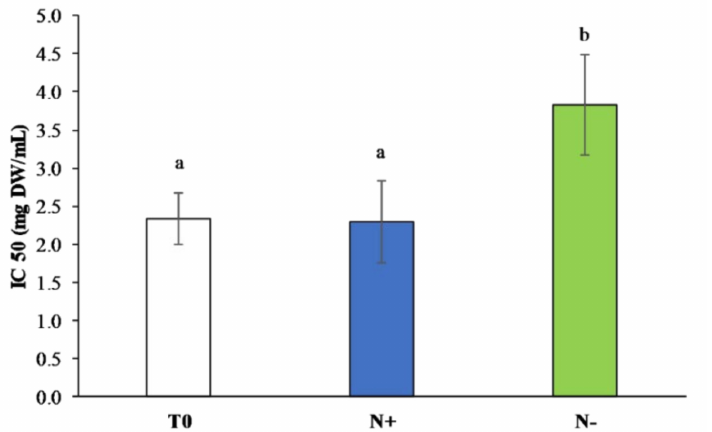
Figure 7. DPPH radical scavenging activity (IC 50, mg DW/mL) in P. tricornutum extracts cultivated for 15 days under initial culture conditions (T0, white bar), under standard conditions (N+, blue bar), and under starvation conditions (N − , green bar). Values are reported as the means ( n = 3), and error bars report the standard deviations. Treatments that do not share the same letter were significantly different from each other ( p <